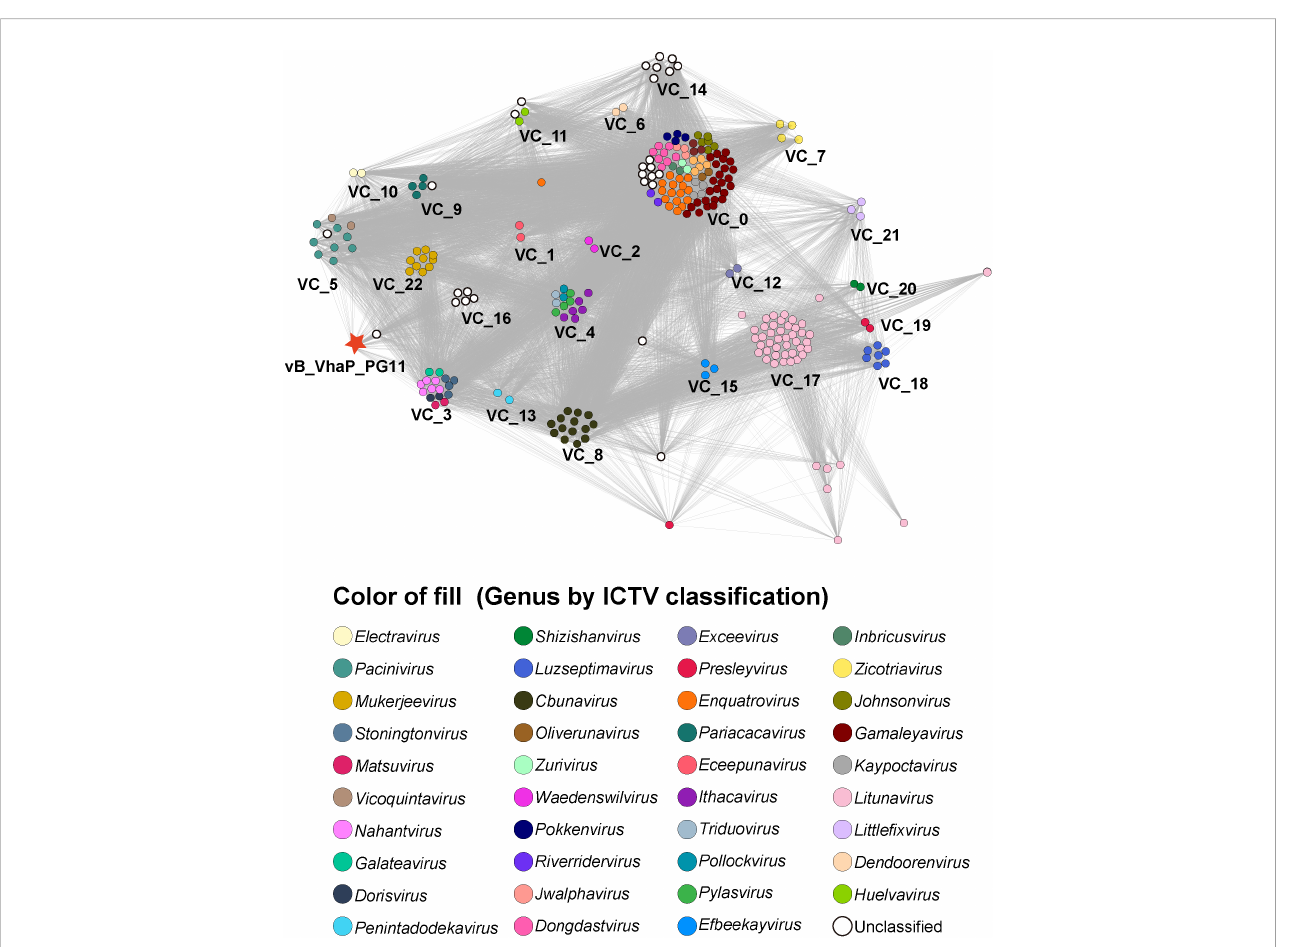
FIGURE 6 Network analysis based on genomes of Vibrio phage vB_VhaP_PG11 and all members of Schitoviridae from NCBI virus database. Each node represents a viral sequence and is colored according to genus. Viral clusters (VCs) are identi fi ed using ClusterONE with default parameters which are de fi ned in the vConTACT